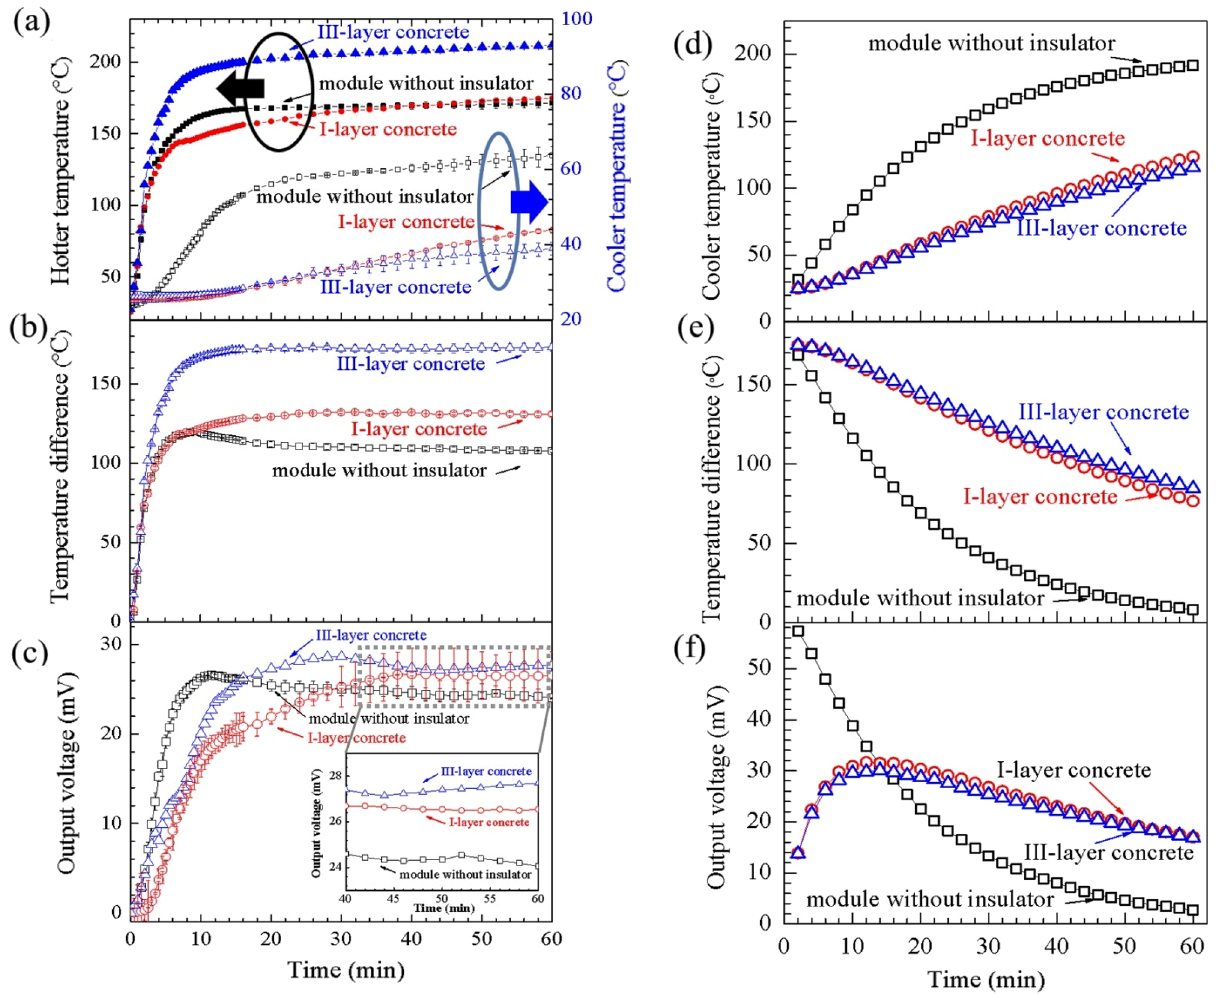
Figure 11. ( a – c ) The experimental results and ( d – f ) The FEM simulation results of hotter and cooler temperature, ( a , d ), temperature difference, ( b , e ) output voltage, ( c , f ) during the target hotter temperature of 200 °C as a function of time